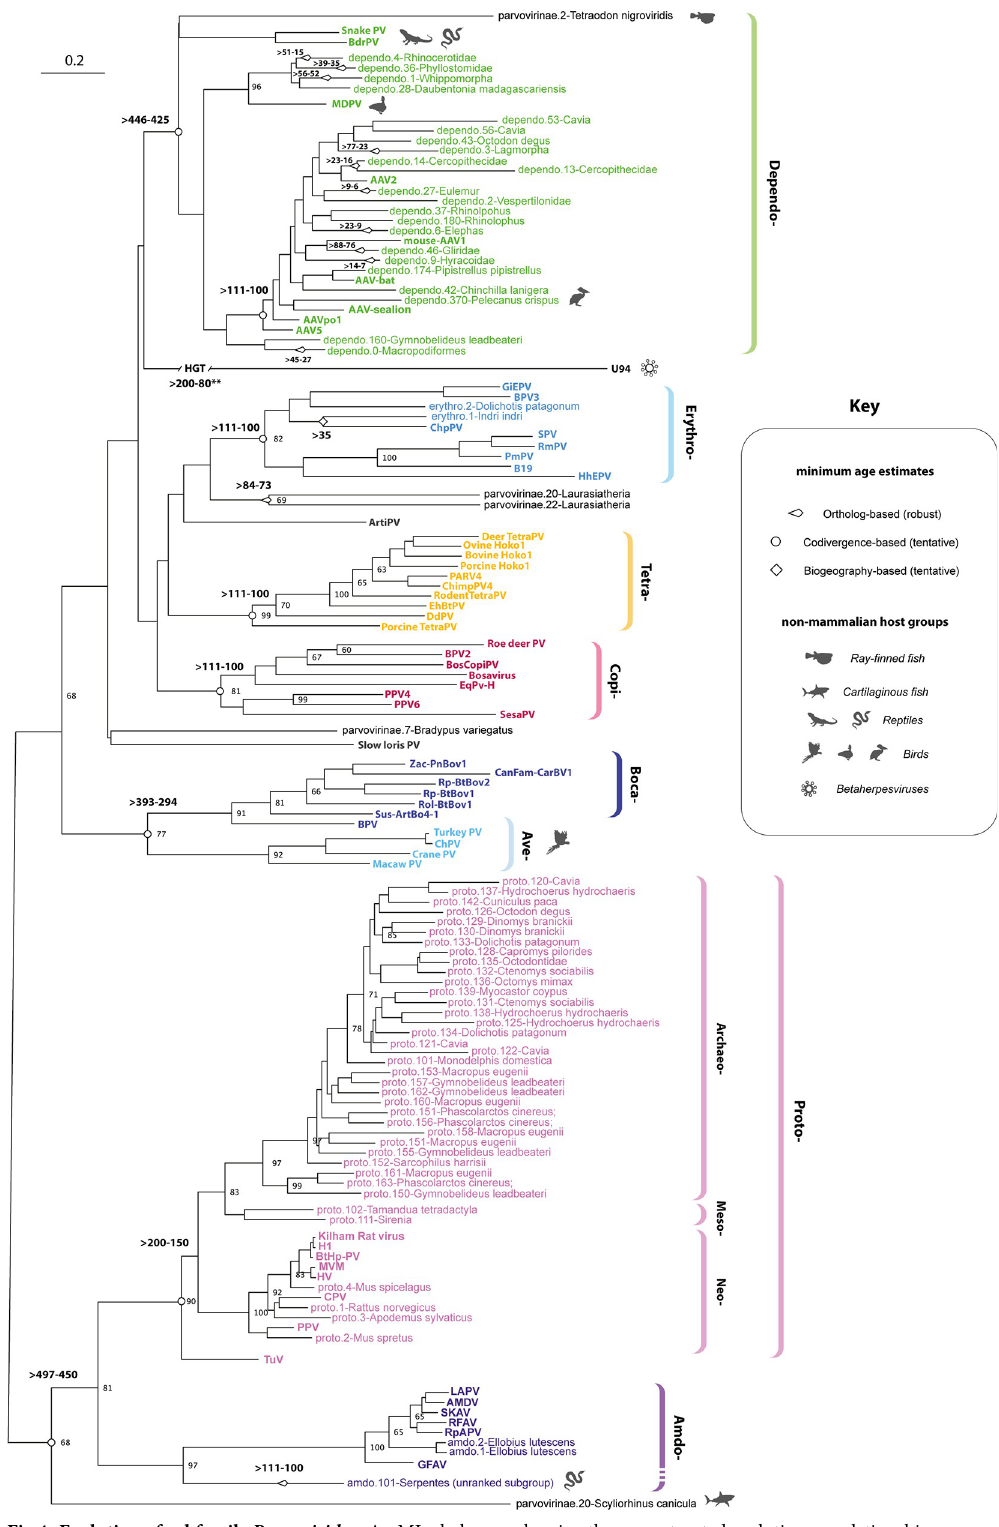
Fig 4. Evolution of subfamily Parvoviridae . An ML phylogeny showing the reconstructed evolutionary relationships between contemporary parvoviruses of subfamily Parvovirinae and the EPVs derived from subfamily Parvovirinae . The phylogeny, which is midpoint rooted for display purposes, was reconstructed using an MSA spanning 270 amino acid